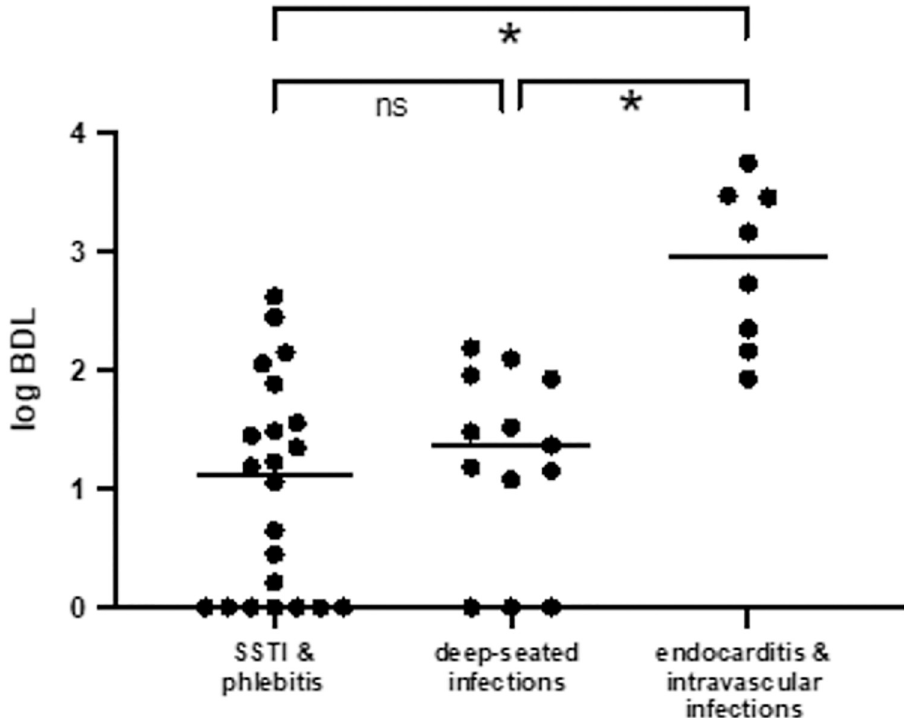
Fig 1. Bacterial DNA loads in three infection categories. SSTI = skin and soft tissue infections; BDL = bacterial DNA load; ns = non-significant difference; = significant difference.